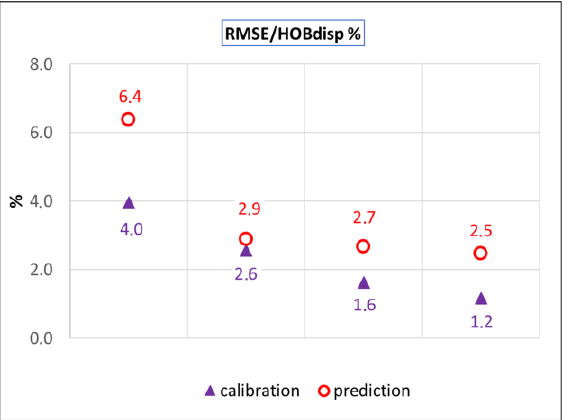
Figure 12. RMSE of groundwater head residuals and observed head dispersion (HOBdisp%) ratio of model variants (V1–V4) for calibration and prediction.